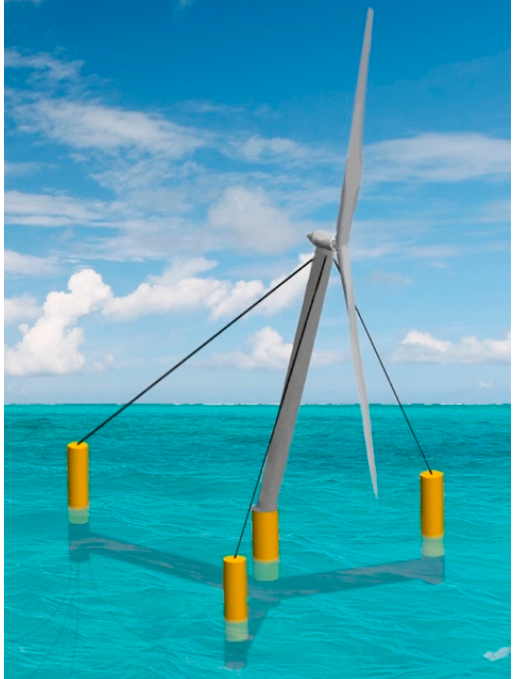
Figure 1. Conceptual idea of the floating offshore wind turbine (FOWT) with guy wires and light-weight structure.